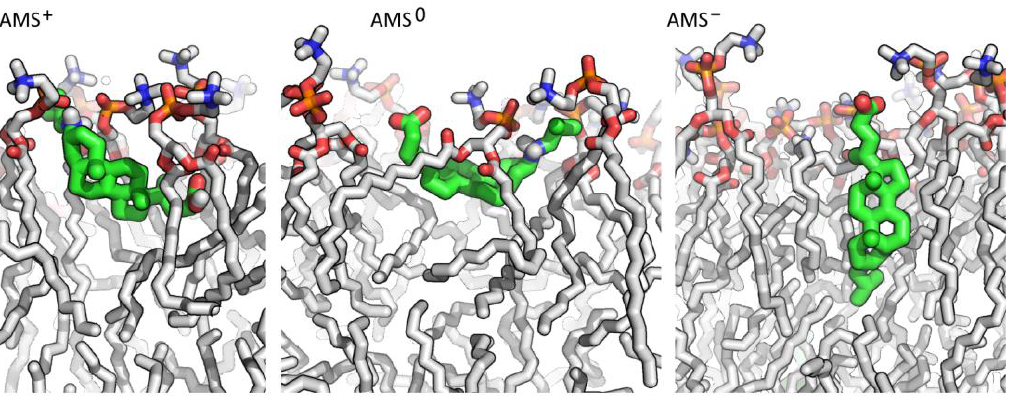
Figure 4. Typical poses of the cationic, zwitterionic, and anionic forms of AMS in the lipid membrane. AMS and lipid molecules are shown in stick representation and colored according to the atom types: green and gray for carbons in AMS and lipids, respectively; polar hydrogen atoms of AMS are colored in white; other hydrogen atoms are hidden.